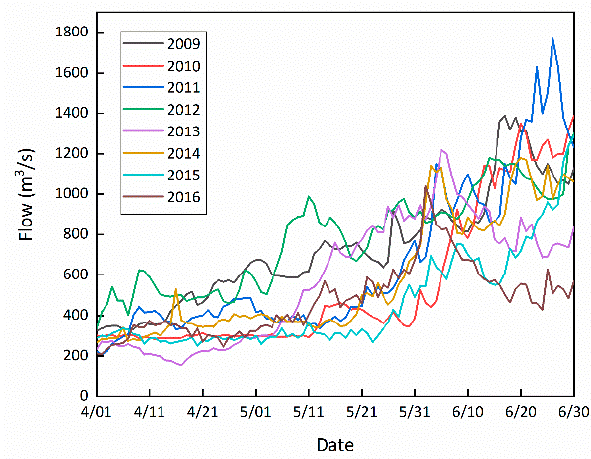
Figure 2. Natural flow processes in different years. Table 2. Characteristic parameters of natural flow process in di ff erent